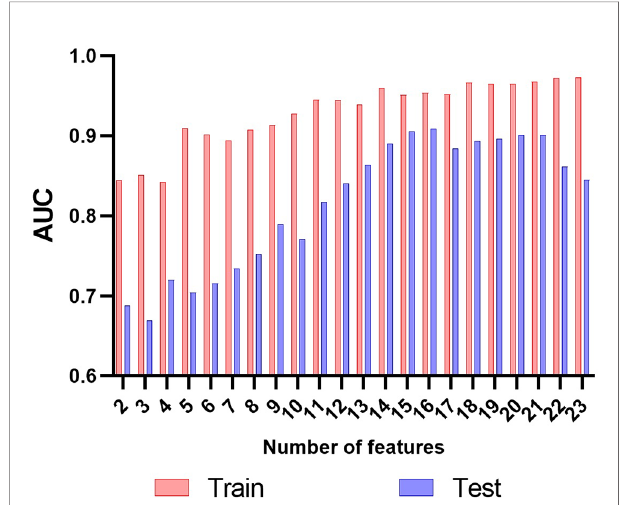
FIGURE 4 | The results of the AUC in radiomics feature selection. The results of the AUC showed that the features at 14 got a good performance both in the training cohort and in the testing